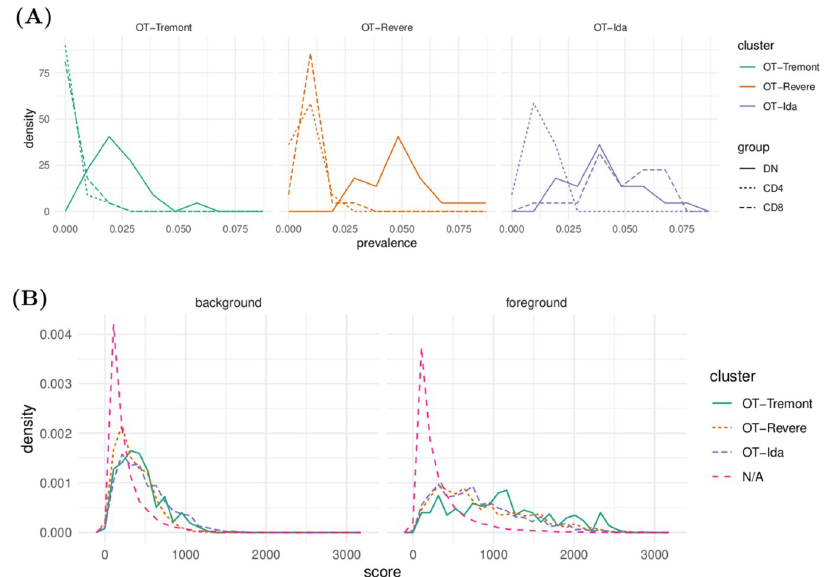
Fig 5. Plots of several statistics that describe the across-repertoire dynamics of the OT-Tremont, OT-Revere, and OT-Ida clusters. (A) Distributions of cluster prevalence across combined repertoires, stratified by cluster and cell type. The DN distributions are consistently to the right of the CD4 distributions, showing that our algorithm is finding motifs that are highly represented in the DN repertoire compared to the CD4 repertoire. (B) Distributions of neighborhood loneliness scores across individual repertoires, stratified by cell type group (background/foreground) and cluster. N/A means not assigned to a cluster. We again see that the motifs distinguish DN sequences from CD4 sequences above the level of per-repertoire